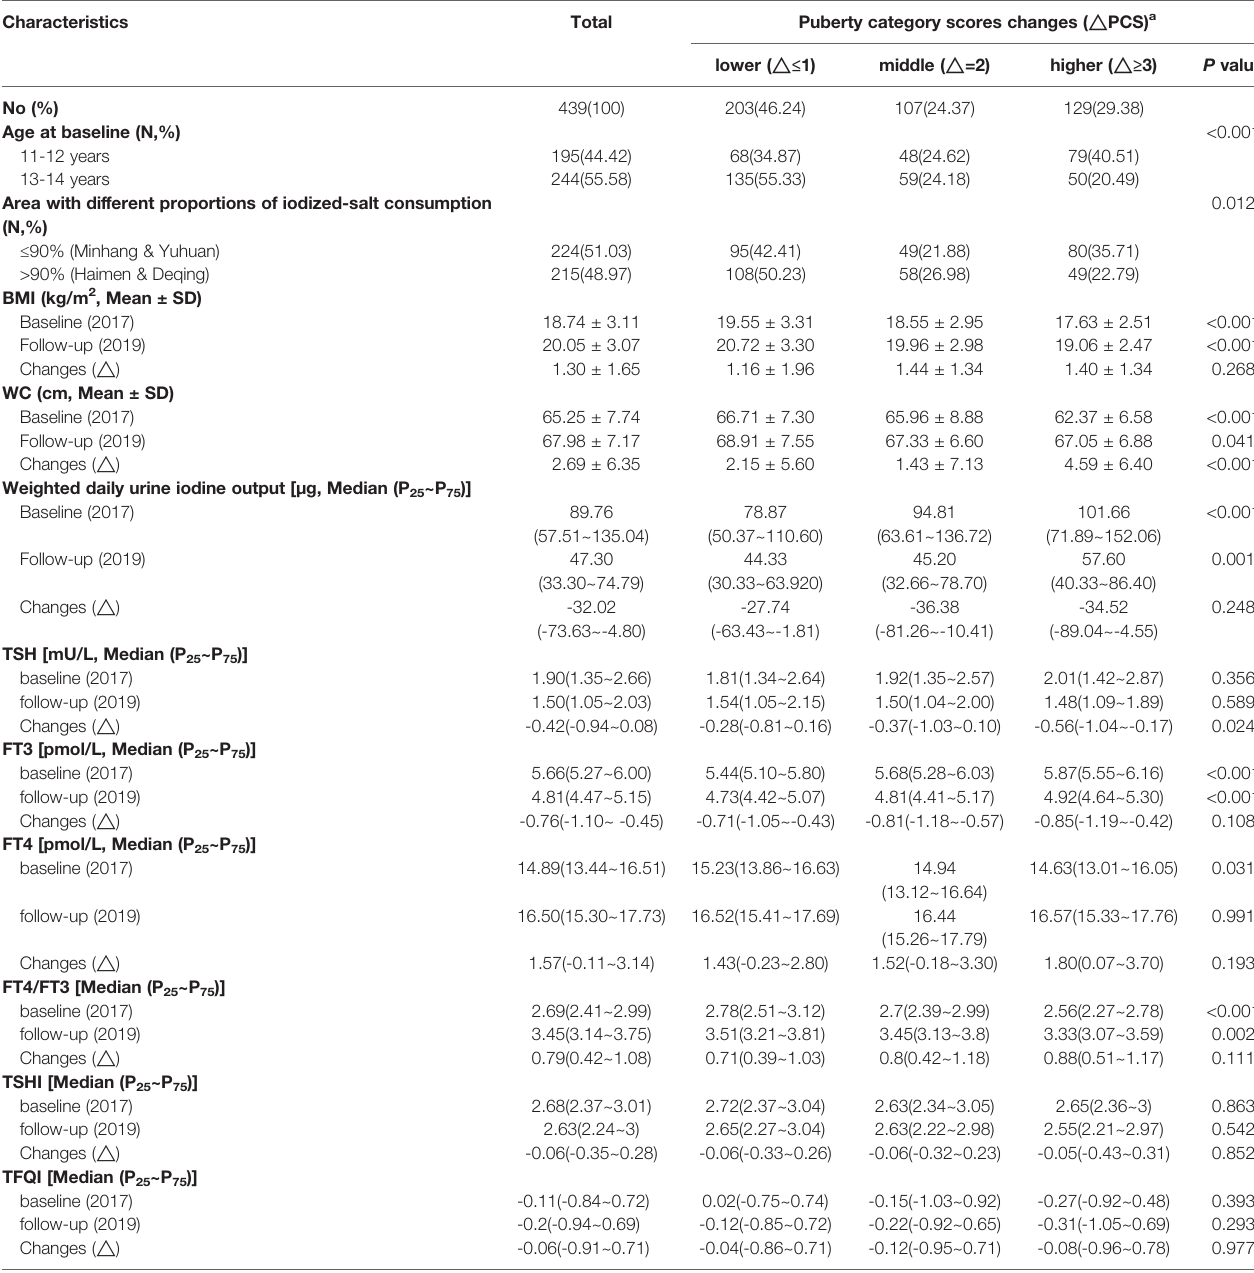
TABLE 1 | Characteristics, anthropometric indexes, thyroid hormones (THs), and thyroid homeostasis structure parameters (THSPs) of girls with different puberty category score (PCS) changes.